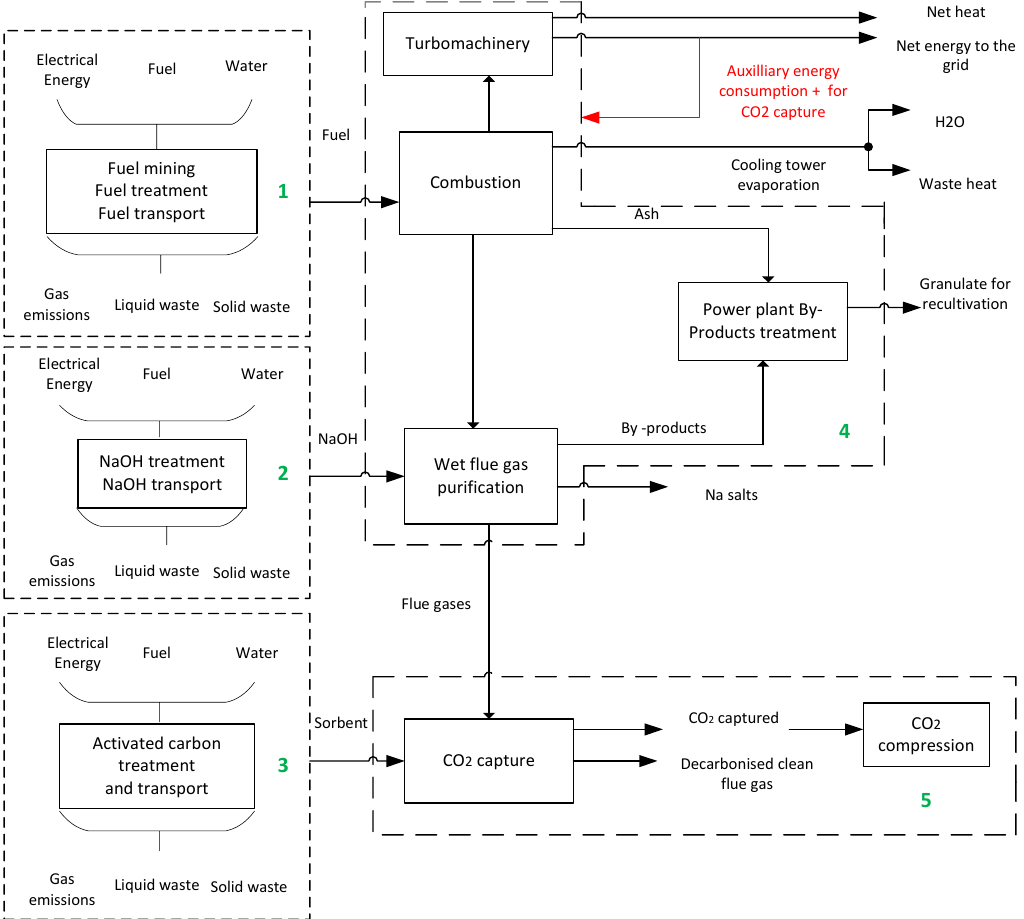
Figure 2. System boundaries for Scenario 2 (red marked is the energy returning back to the system; dashed lines with numbers represent technological segments).